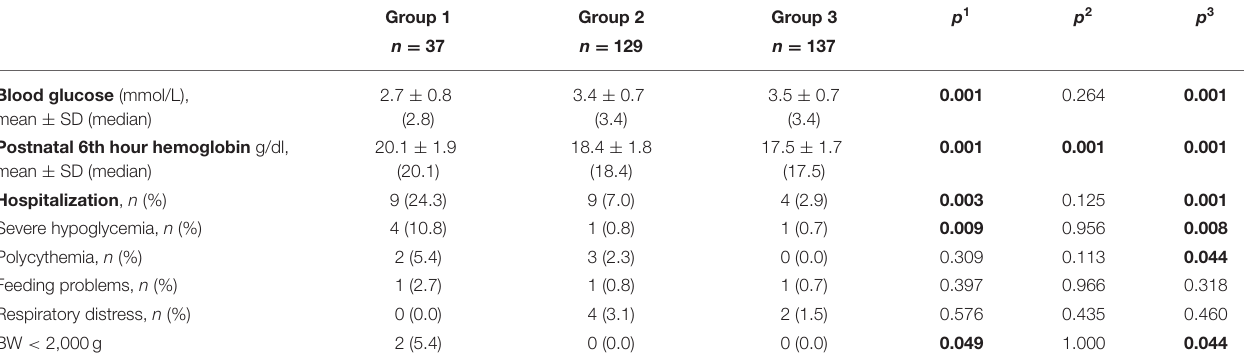
TABLE 2 | Clinical characteristics and incidences of neonatal morbidities of the study population. Group 1 Group 2 Group 3 p 1